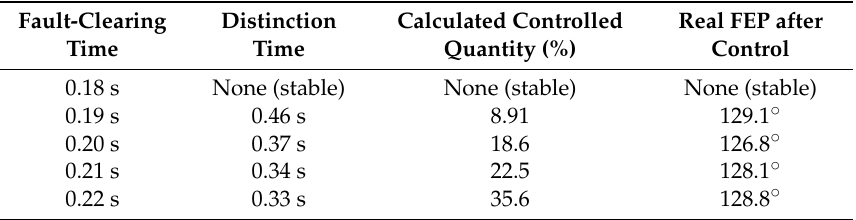
Table 5. Calculated minimum control by limiting the maximum